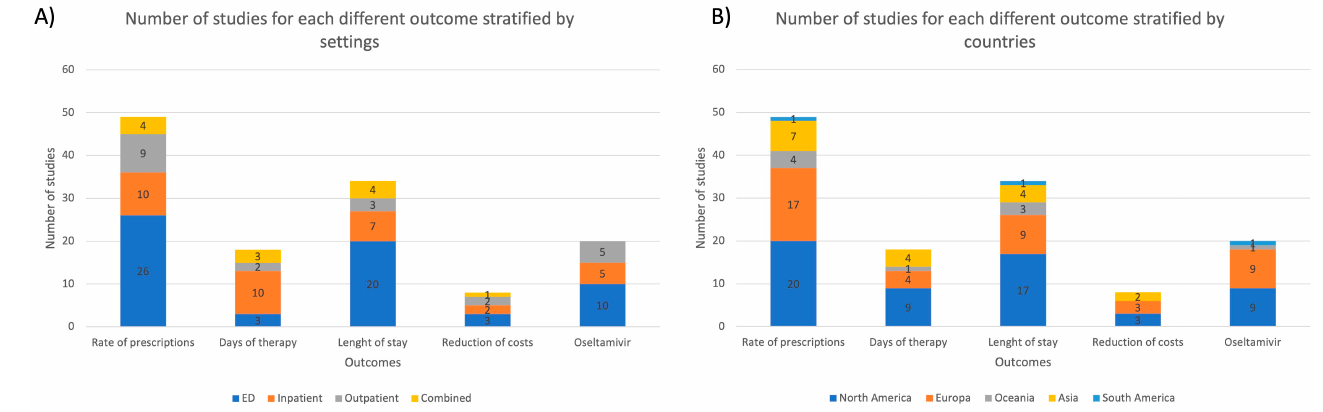
Figure 3. The number of studies for each different outcome stratified by ( A ) settings; ( B ) countries; ED = emergency